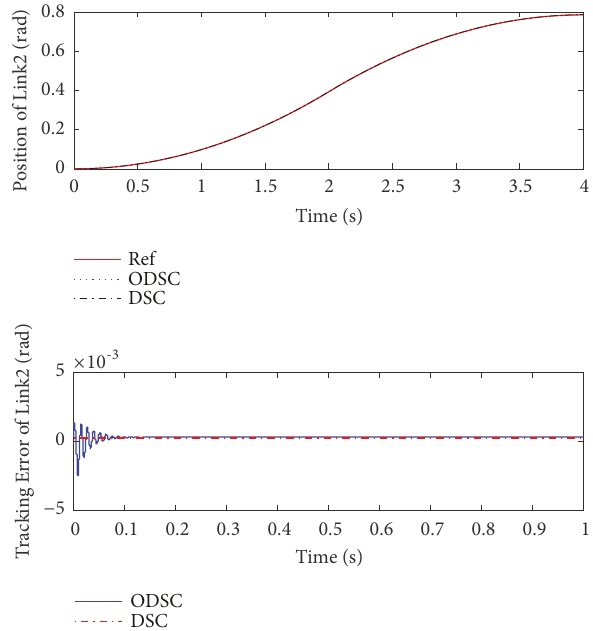
Figure 4: The position and tracking error of link2.